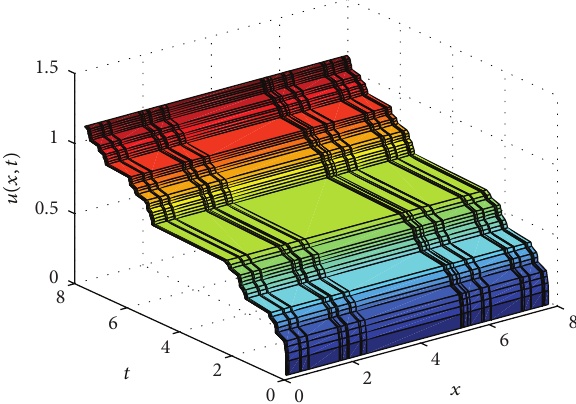
Figure 2: Solution for the one-dimensional heat equations with a fixed value 𝛼 = ln 2/ ln 3 .